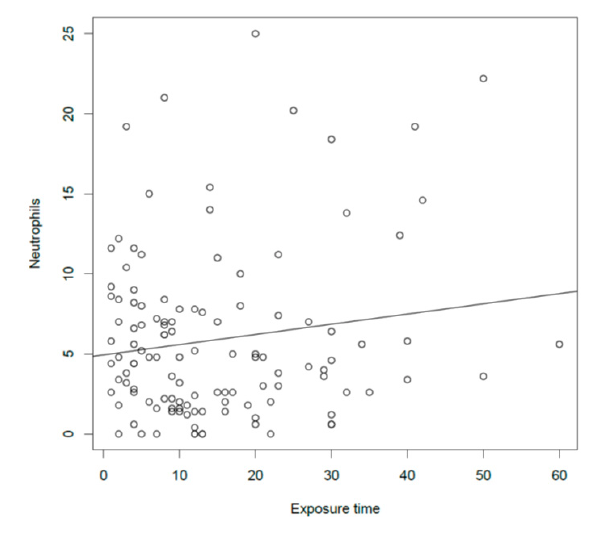
Figure 6. Correlation between the number of neutrophils at nasal cytology and the exposure time.